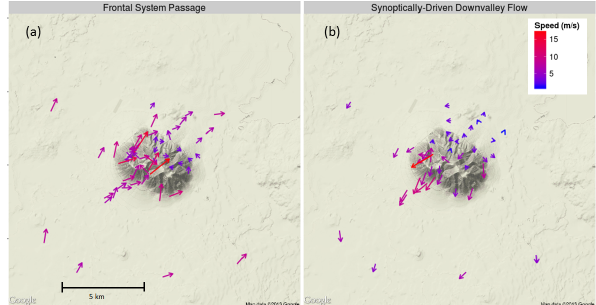
Figure 10. Characteristic synoptically driven regime events during (a) the passage of a frontal system (18:00 LT) and (b) during synop- tically enhanced downvalley flow on the Snake River Plain (23:00 LT) at Big Southern Butte during June–September 2010. Vectors represent the average hourly flow at a given sensor. Periods of weak synoptic forcing were removed prior to averaging. The lower strip is zoomed out to show the entire study